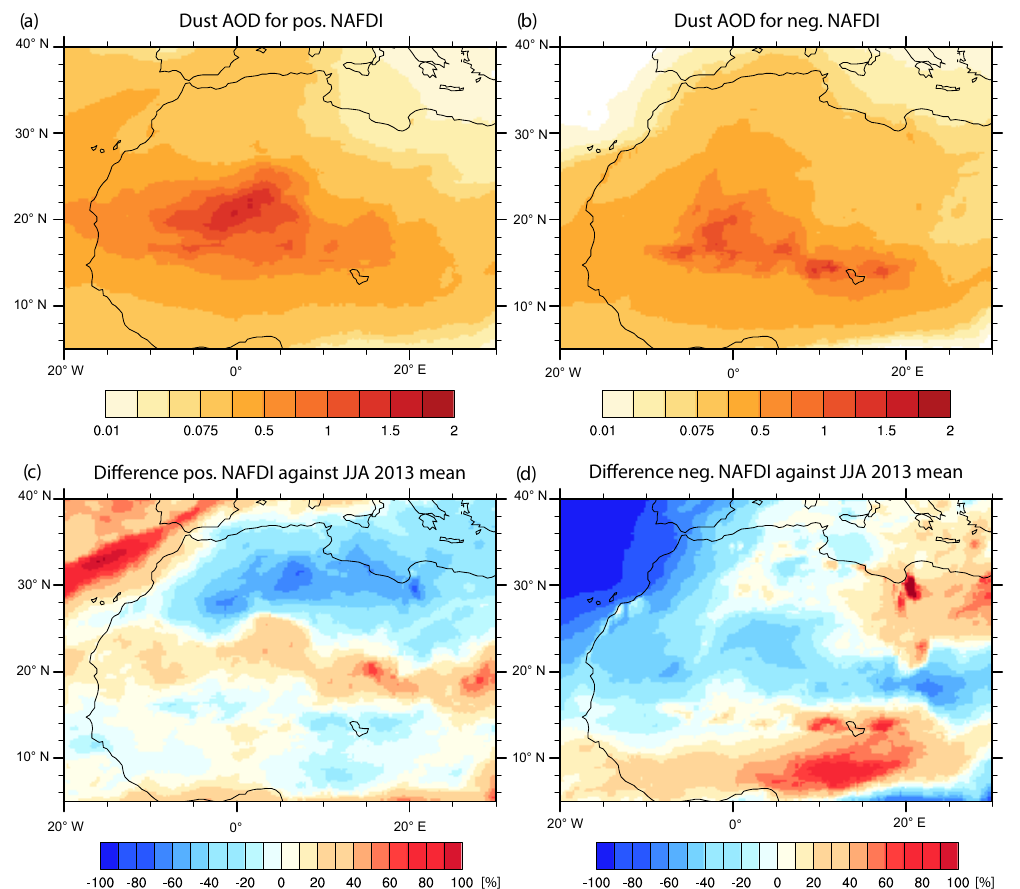
Figure 6. Composite of dust AOD for days within the 75th percentile (a) and 25th percentile (b) of the NAFDI index values. Panels (c) and (d) show the relative difference to the JJA 2013